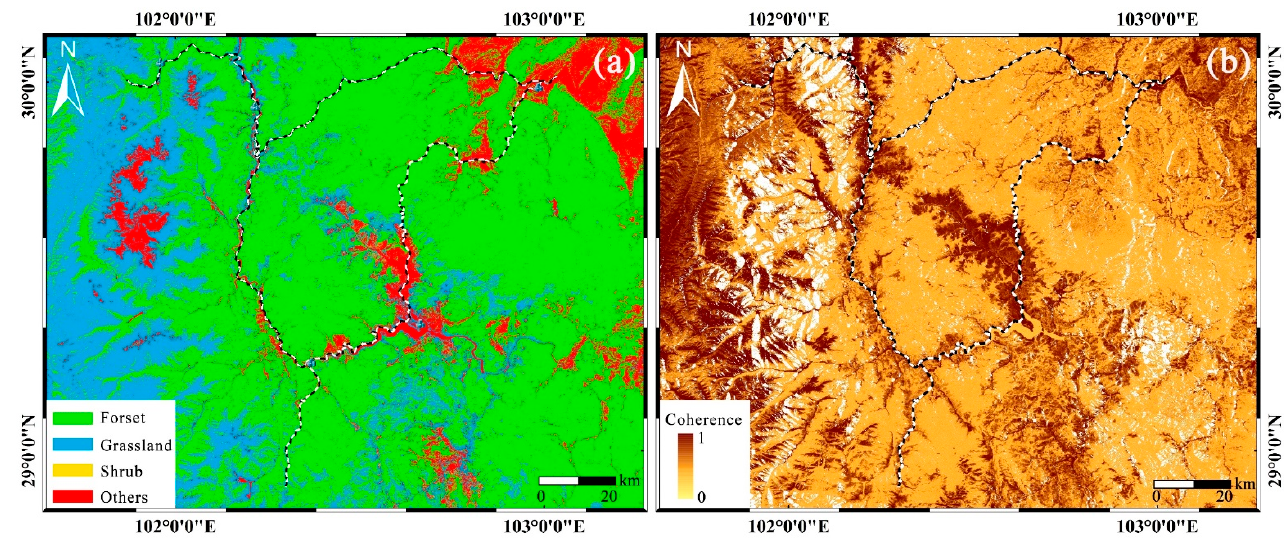
Figure 2. Suitability analysis of InSAR: ( a ) land cover, and ( b ) map of the average coherence during the period from October 2017 to July 2021.